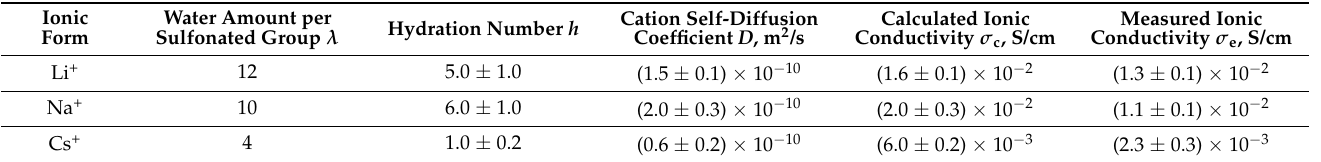
Table 6. Water content λ , hydration number h , self-diffusion coefficients D , calculated conductivity σ c , measured conductivity σ e of Li + , Na + , and Cs + cations in Li + , Na + , and Cs + Nafion 117 membrane ionic forms, RH = 98%, t = 20 ◦ C. Reprinted with permission from Ref. [60]. Copyright © 2022 Elsevier B.V. All rights